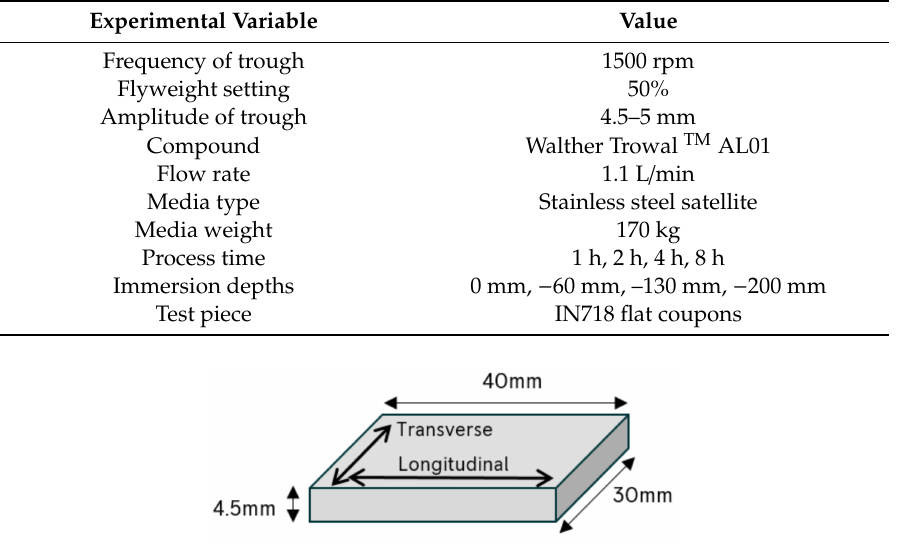
Figure 8. IN718 flat coupon